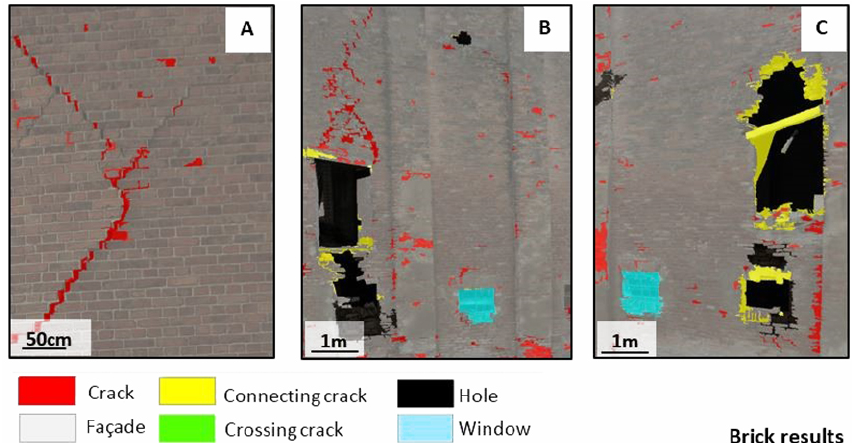
Figure 9. Results of applying the brick rule set on three brick façade images. Scale approx.